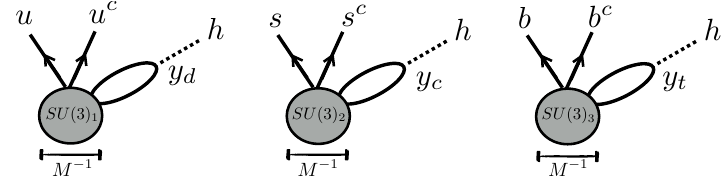
Figure 4 . Schematically, high energy instantons act separately at scales above M to generate one of the Yukawa couplings in each individual SU(3)